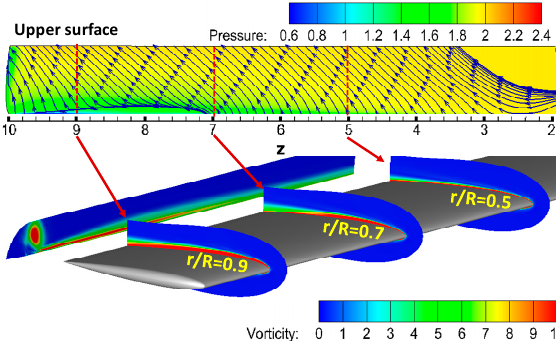
Figure 14. Streamline and vorticity contour distributions on wing surface.